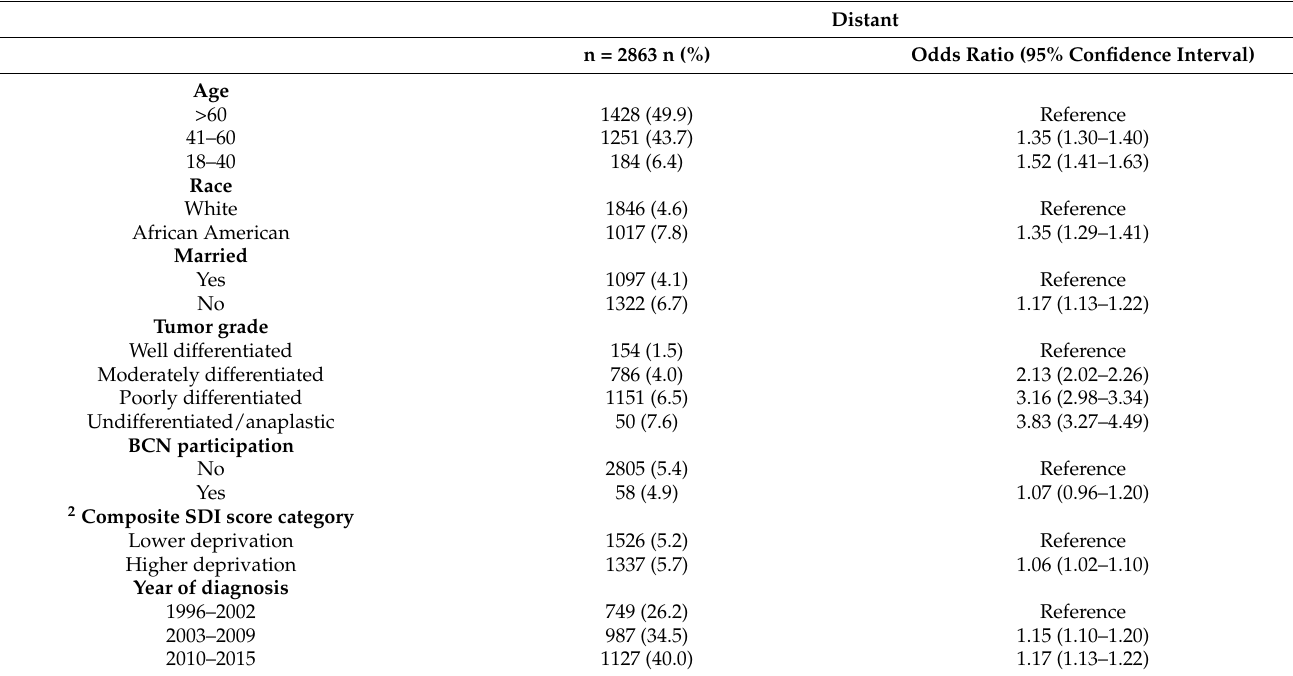
Table 2. Multivariable analysis of predictors of distant breast cancer staging (ordinal regression model) 1 . Distant n = 2863 n (%) Odds Ratio (95% Confidence